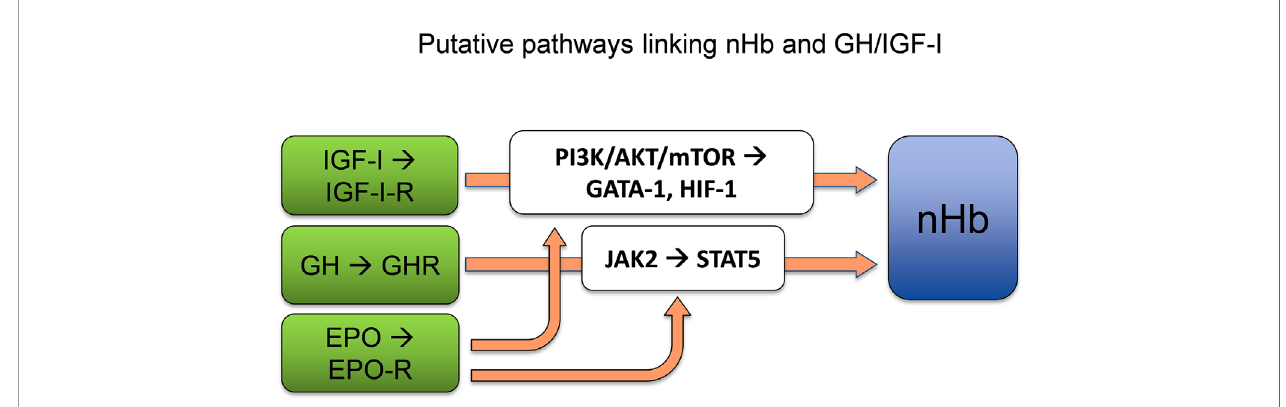
FIGURE 2 | GH and/or IGF-I act as signi fi cant determinants of Hb concentrations by adapting adequate levels of Hb to the oxygen demand. STAT5, which is a key transcription factor of GH, is suf fi cient to allow erythropoiesis and myelopoiesis in vitro and in vivo. The PI3K/AKT/mTOR pathways lie downstream of the IGF-I- receptor. AKT phosphorylation of GATA-1 and its partner FOG-1 coordinates erythroid proliferation and differentiation. HIF-1 induced by IGF-I regulates the supply of oxygen to the cell by creating a balance between oxygen demand and oxygen supply. nHb, Neuronal hemoglobin; GH, growth hormone; IGF-I, insulin-like growth factor 1; STAT5, signal transducer and activator of transcription 5; PI3K/AKT/mTOR, phosphoinositide 3-kinases/protein kinase B/mammalian target of rapamycin; GATA-1, globin transcription factor 1; HIF-1, hypoxia inducible factor 1; FOG-1, friend-of-GATA1. References for the depicted relationships are given in main